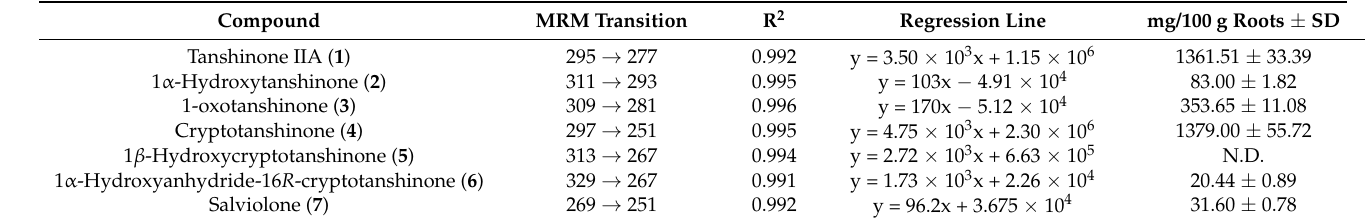
Table 1. Quantitative results of compounds 1 – 7 occurring in the EtOH extract of S. miltiorrhiza